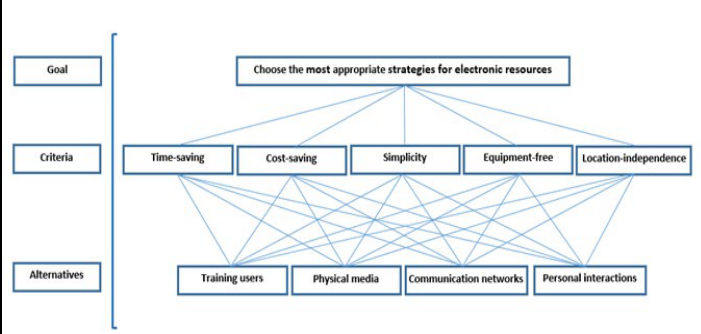
Figure 1 Hierarchical structure for choosing the best strategies for electronic resources